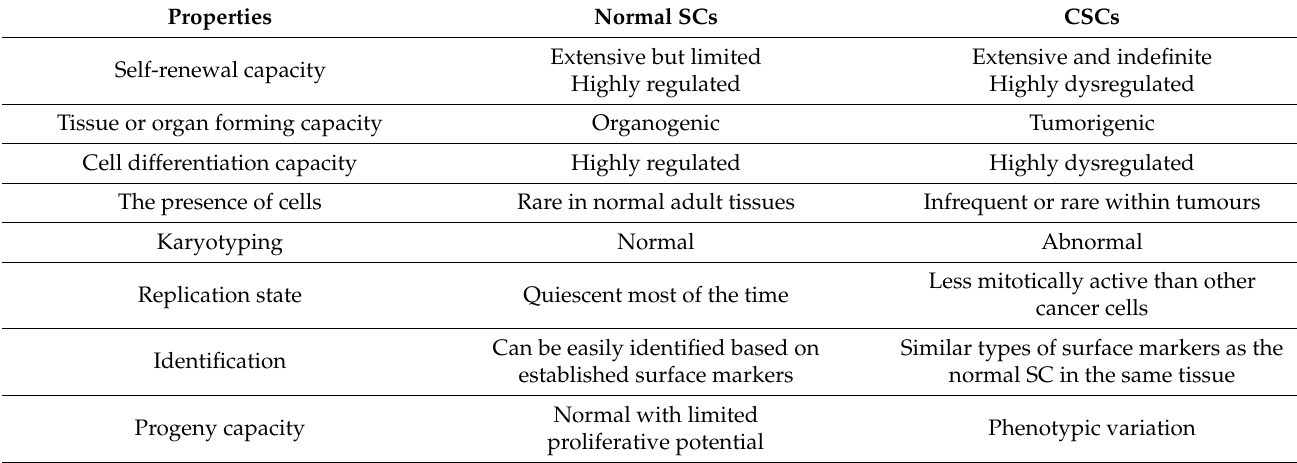
Table 2. Normal SCs properties vs CSCs properties (Adapted from Cetin and Topcul 2012).